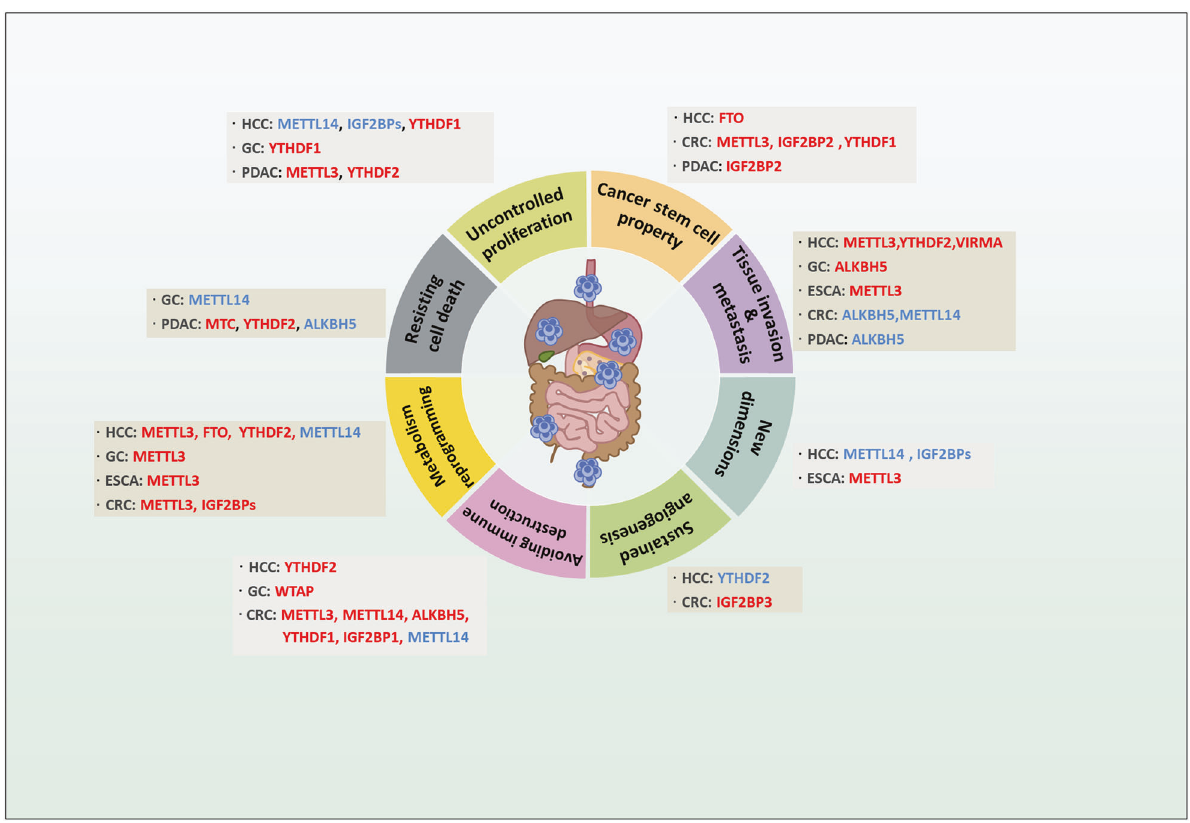
Fig. 2 Dysregulation of m 6 A regulators in the hallmarks of GI cancer. Regulators in red represent oncogenic roles in regulating hallmarks of GI and related cancers, and those in blue indicate tumor-suppressive roles. CRC colorectal cancer, ESCA esophageal carcinoma, GC gastric cancer, HCC hepatocellular cancer, PDAC pancreatic ductal